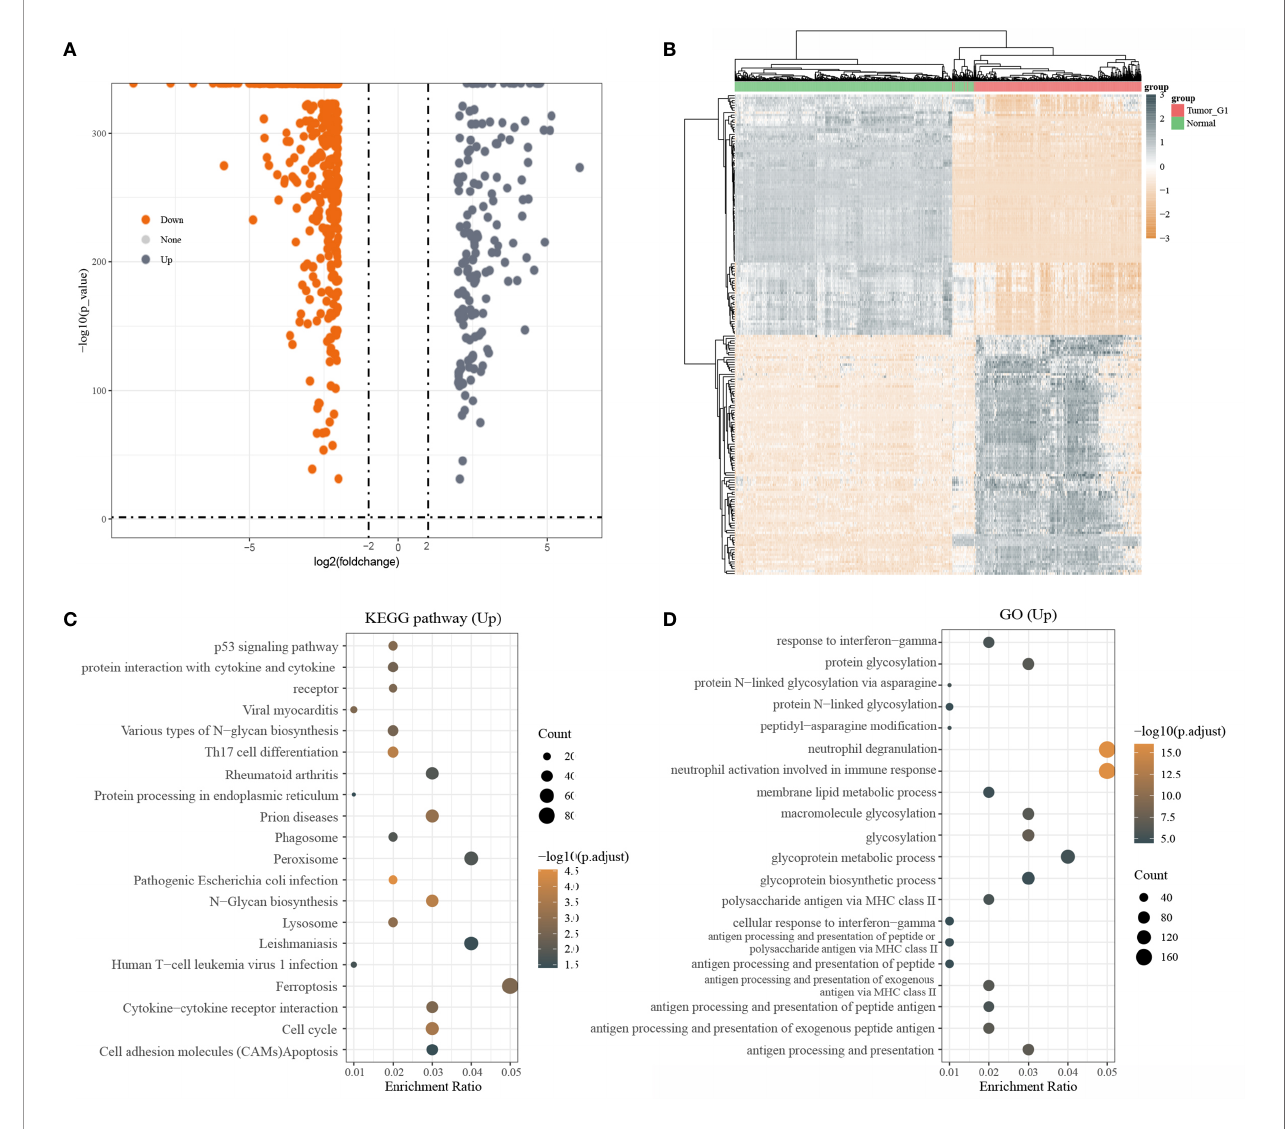
FIGURE 1 | Differentially expressed genes and functional enrichment analysis; (A) volcano plot: grey dots indicate signi fi cantly differentially up-regulated genes and orange dots indicate signi fi cantly differentially down-regulated genes; (B) Heatmap plot of the DEGs; (C) KEGG enrichment analysis; (D) GO enrichment